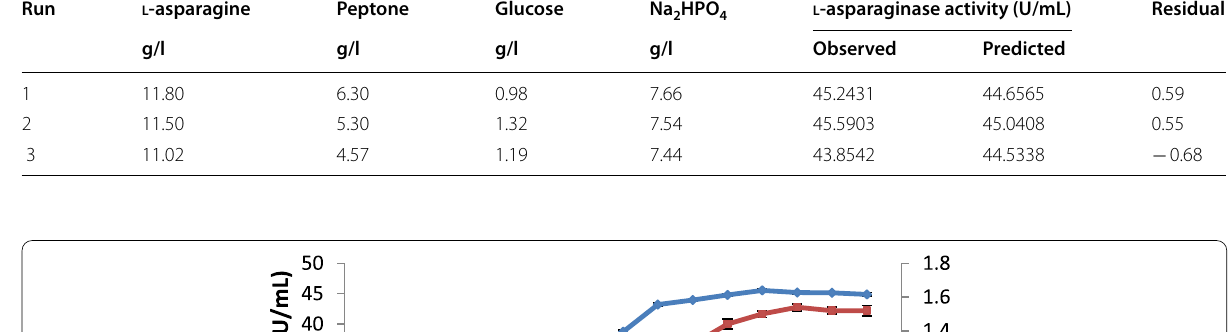
Table 7 Validation of the model Run